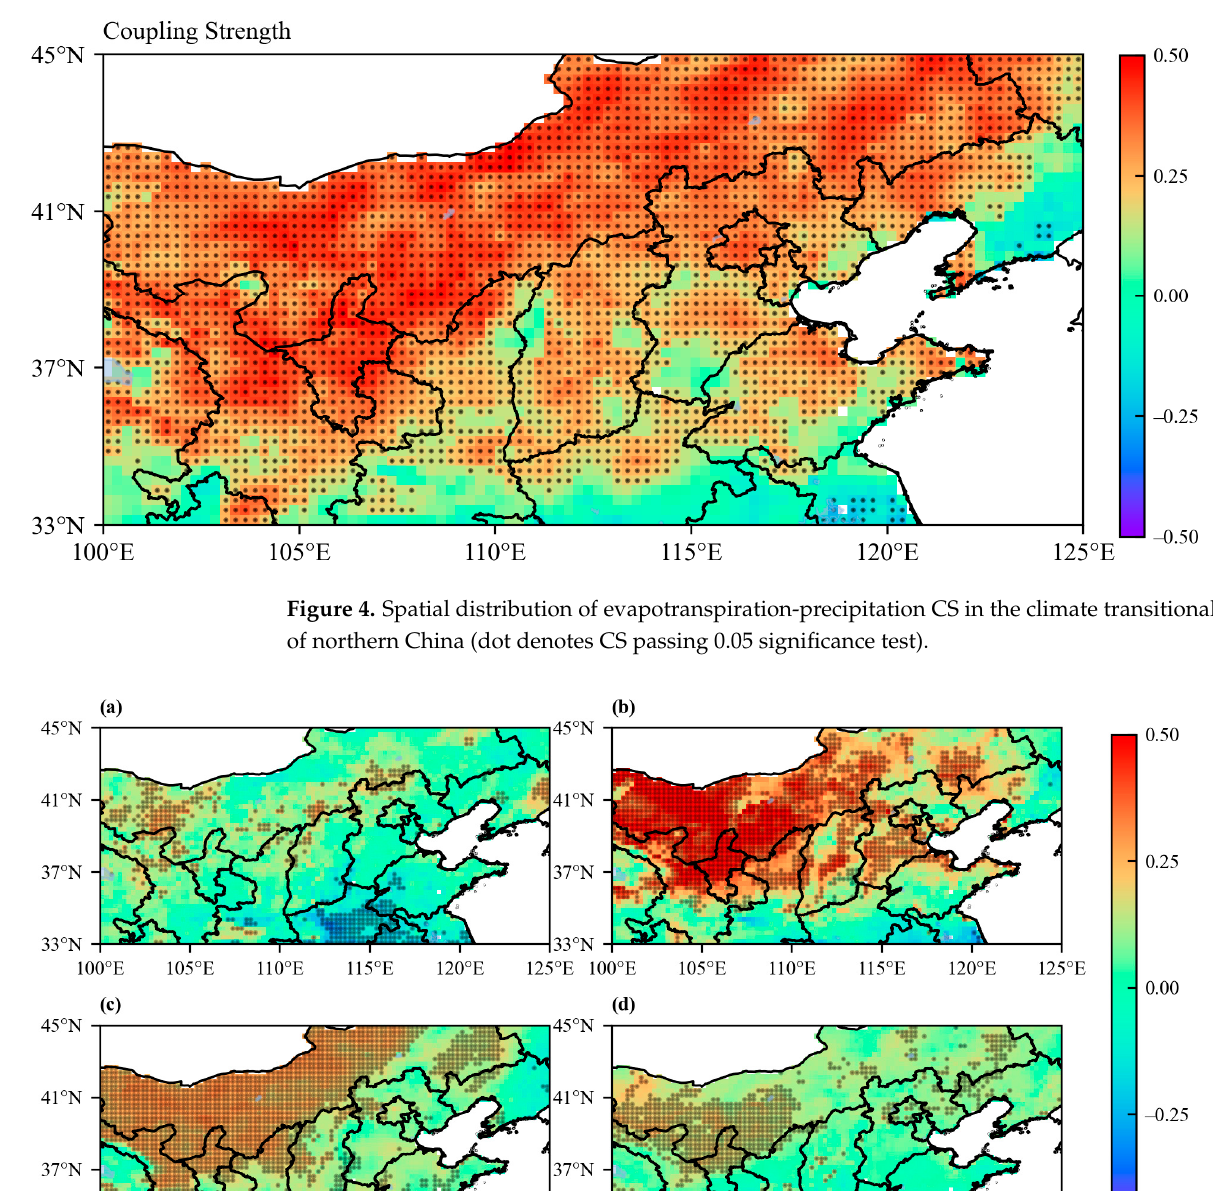
Figure 5. Seasonal changes in spatial distribution of evapotranspiration–precipitation CS in the climate transitional zone of northern China, ( a ) for winter, ( b ) for spring, ( c ) for summer, and ( d ) for autumn (dot denotes CS passing 0.05 significance test).